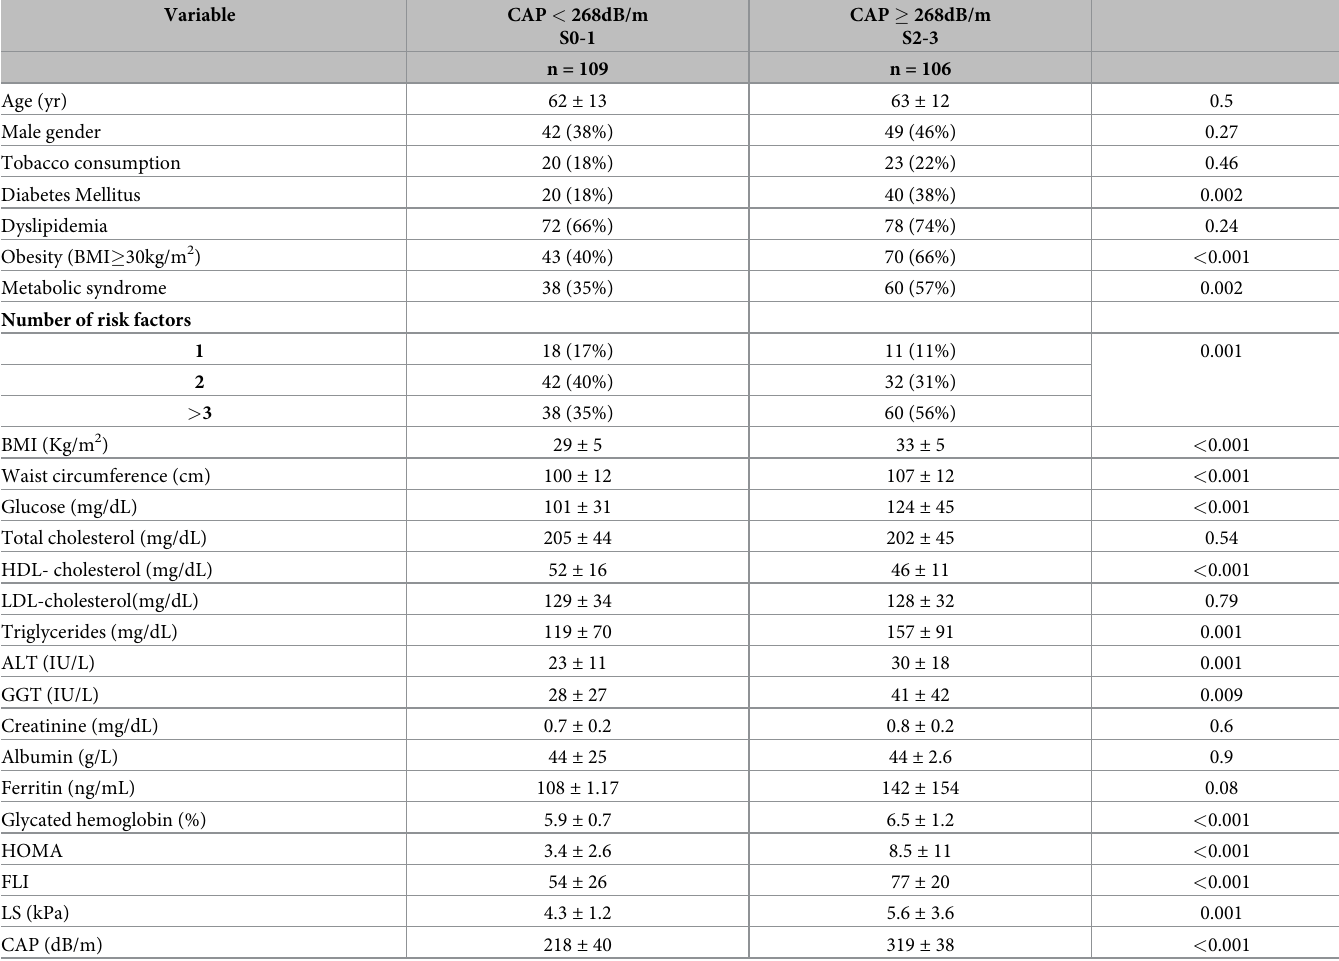
Table 4. Comparison of baseline characteristics of subjects with risk factors for NAFLD categorized according to the presence (S2-3) or absence (S0-1) of moderate- severe steatosis measured by CAP